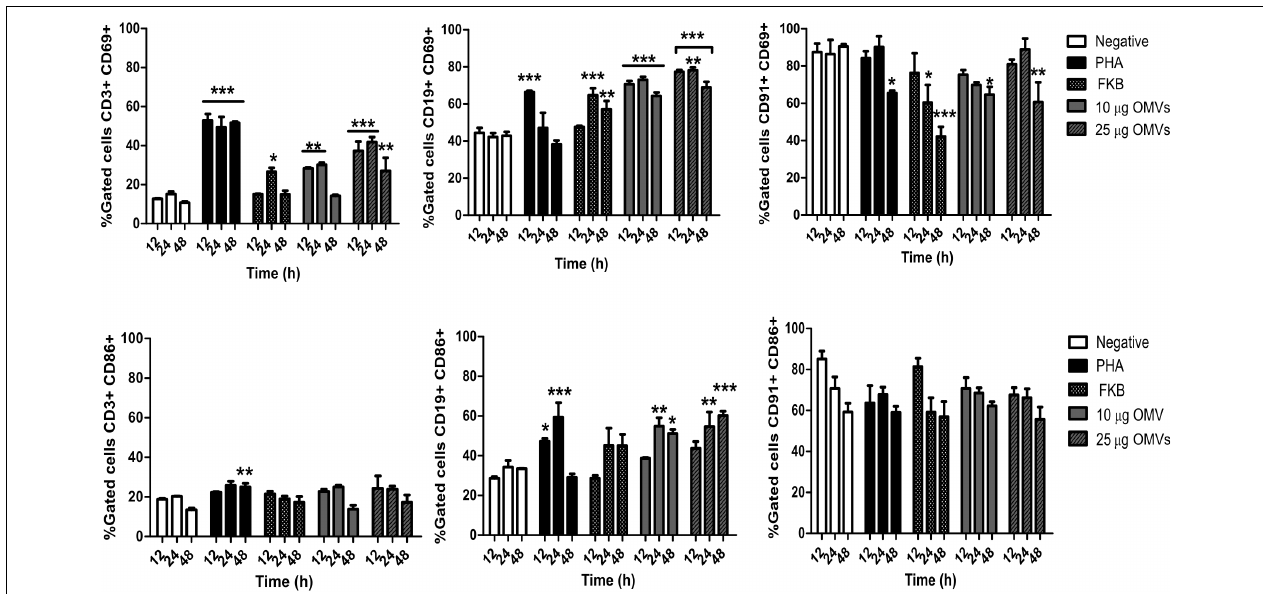
FIGURE 3 | Analysis of expression of activation surface markers in PBMCs stimulated with A. hydrophila ATCC R (cid:13) 7966 TM OMVs. PBMCs from healthy donor were co-cultured with OMVs from A. hydrophila . Activation was measured by flow cytometry using mAbs against surface molecules (CD69, CD86). Monocyte (CD91 + ) and lymphocytes (CD3 + , CD19 + ) were gated to analyze individually the expression of surface molecules. ∗ P < 0.05, ∗∗ P < 0.01, ∗∗∗ P < 0.001.